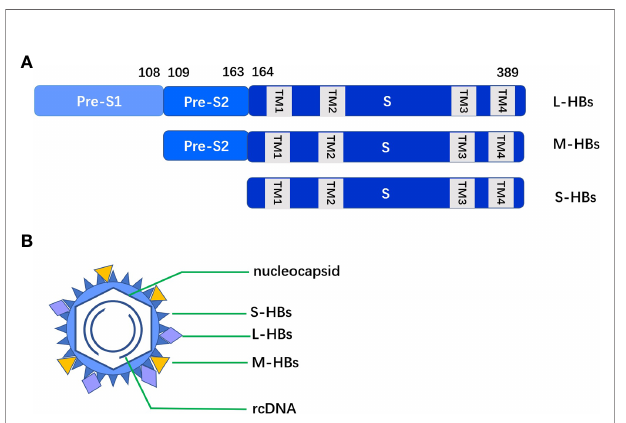
FIGURE 1 | (A) The three S proteins (L-HBs, M-HBs and S-HBs) differ in their N- terminus but share a common S domain with 4 putative TM domains on their C-terminus. (B) Intact HBV particles contain a large amount of S-HBs and the same amount of M-HBs and L-HBs, with a composition ratio of about